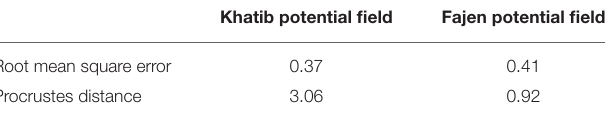
TABLE 1 | Comparison of imitation